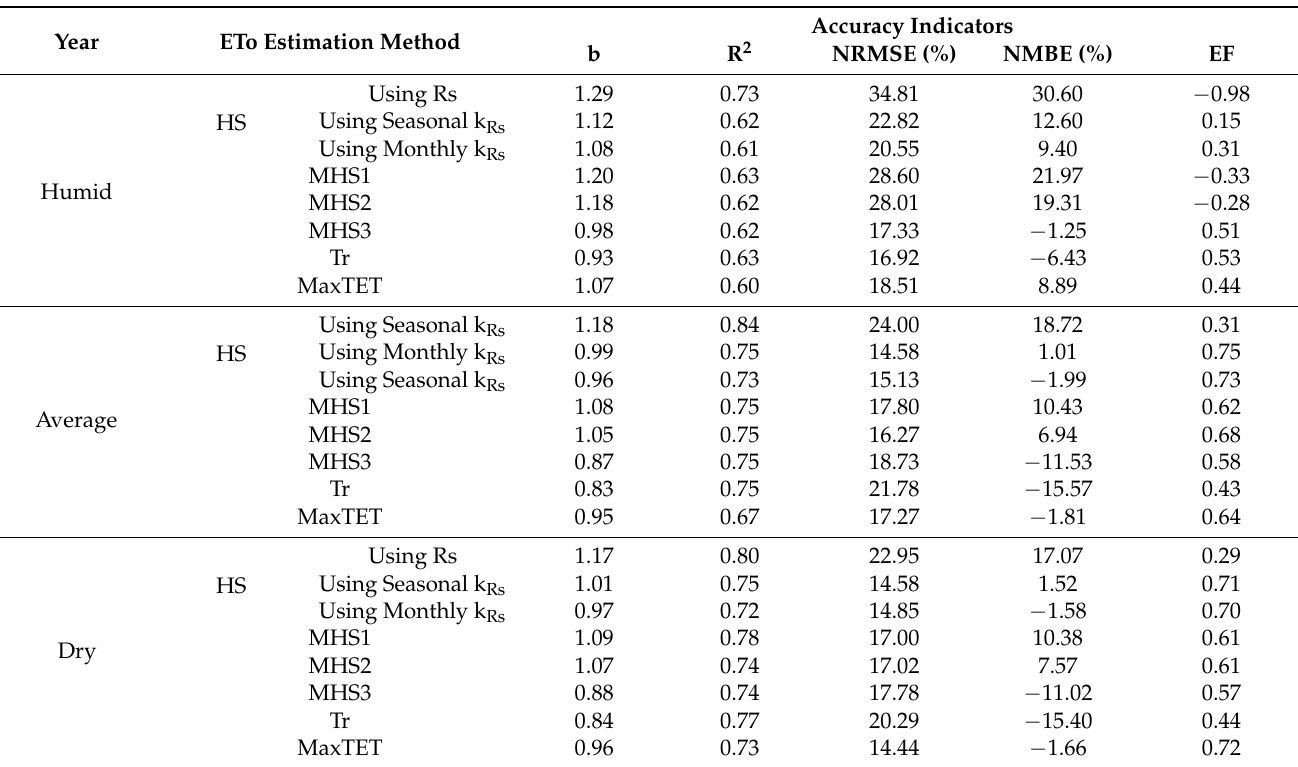
Table 2. Accuracy indicators for the relationship between daily ETo estimated by the Penman–Monteith equation, by the temperature-based equations for Odemira and for three different years–humid, average and